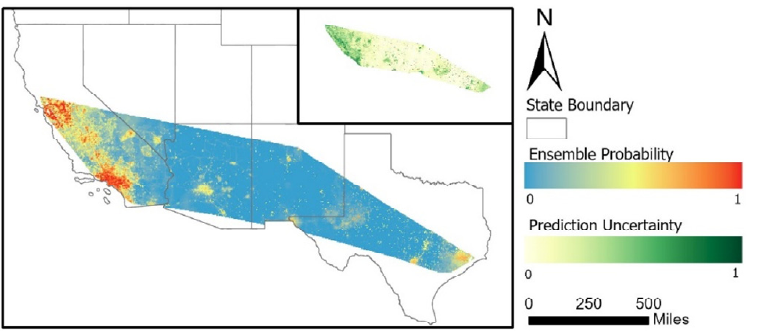
Figure 4. Spatial distributions of the predicted mortality events and the uncertainty in predictions for Barn Owl in the western and central United States in 2020.